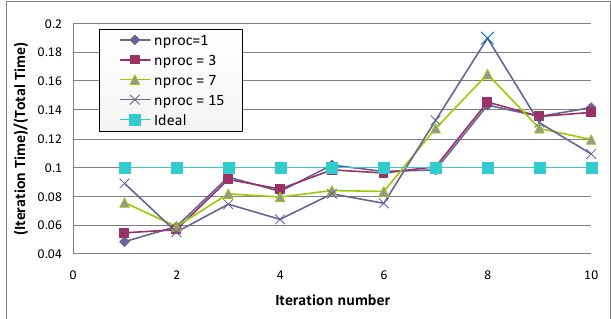
Fig. 9. Histogram of function evaluation times for 3-DV for LB Scheme